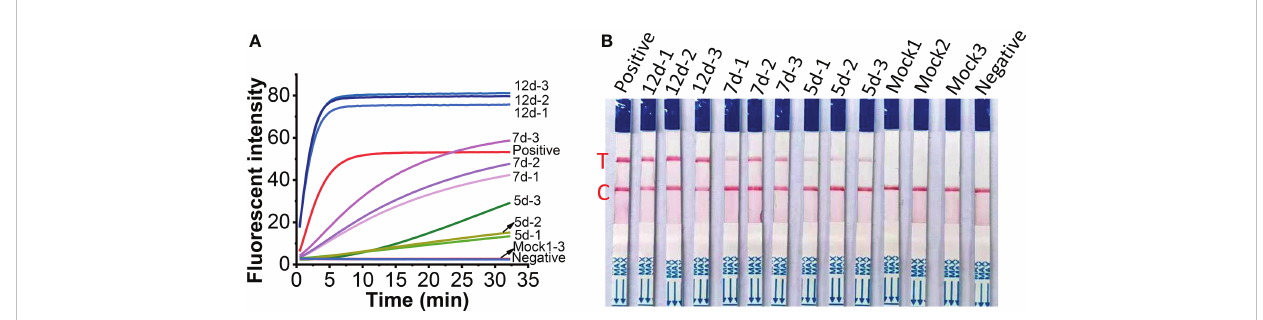
FIGURE 8 Detection of crude extracts of total RNA from MCMV inoculated maize leaves at different day post inoculation (dpi). (A) , one-tube one-step RT-RAA/ Cas12a fl uorescent detection; (B) , one-tube one-step RT-RAA/Cas12a lateral fl ow assay. Mock1~3, the mock inoculated maize leaves; 5d-1~5d-2, the MCMV inoculated maize leaves at 5 dpi; 7d-1~7d~3, the MCMV inoculated maize leaves at 7 dpi; 12d-1~12d-3, the MCMV inoculated maize leaves at 12